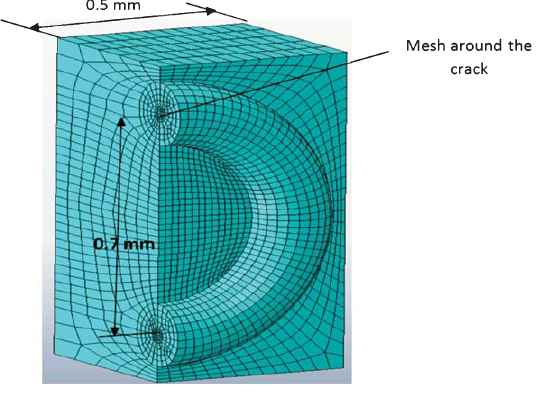
Fig. 9. Refined mesh around the crack front.